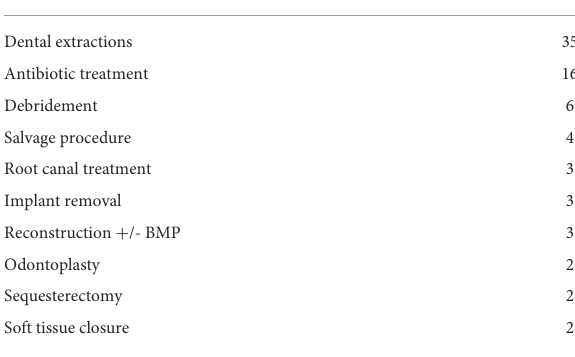
TABLE 4 Additional medical